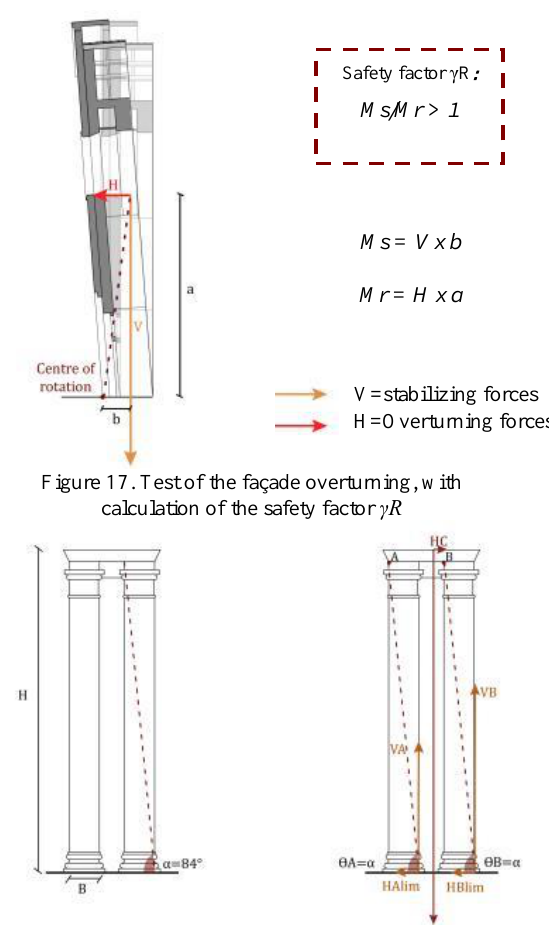
Figure 18. Columns analysis: a) Column limit inclination and b) Horizontal limit reactions at the base of the